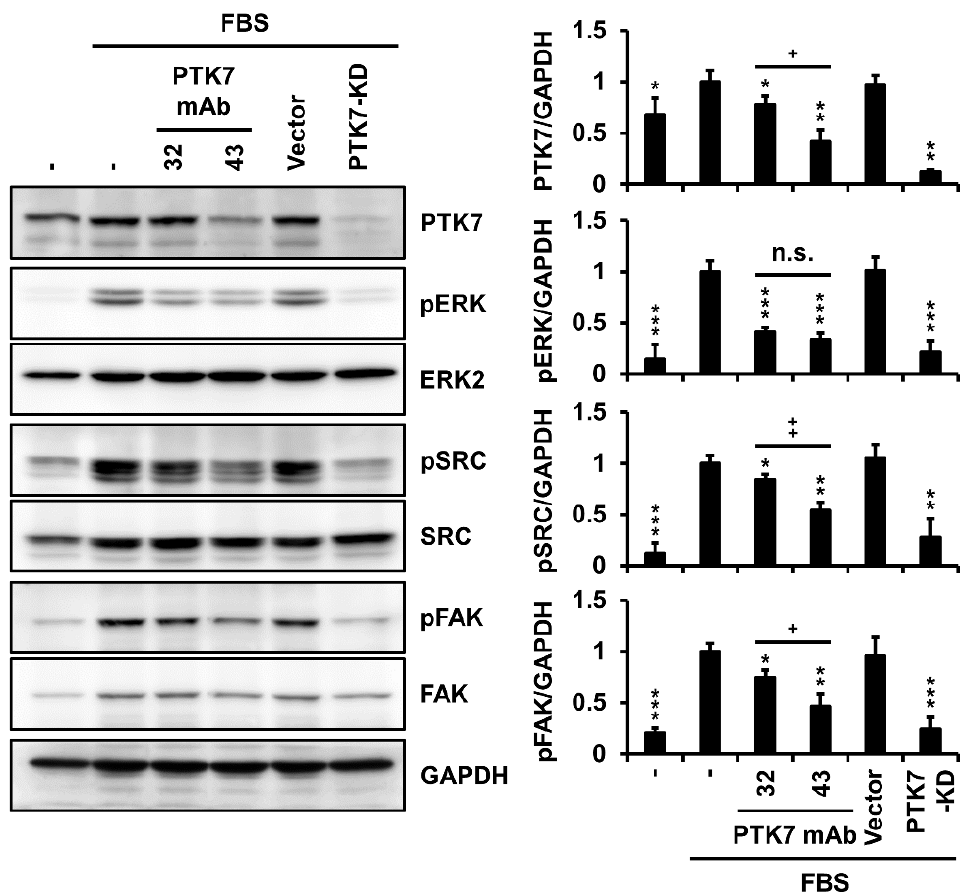
Figure 5. PTK mAbs inhibit activation of ERK, SRC, and FAK in KYSE-30 cells. KYSE-30 cells were incubated in DMEM/F12 medium with or without 2% FBS in the presence of PTK7 mAb (10 μg/mL) for 24 h. KYSE-30 cells infected with the vector or PTK7 knockdown viruses were used as controls. Cell lysates were subjected to Western blot analysis using PTK7, pERK, ERK, pSRC, SRC, pFAK, FAK, and GAPDH antibodies. Phosphoprotein/GAPDH ratio was quantitated using ImageJ software. Each bar represents the mean ± SD of three independent experiments: * p < 0.05, ** p < 0.01, or *** p < 0.001 vs. cells treated with FBS alone; + p < 0.05, ++ p < 0.01, or n.s. (not significant) between PTK7 mAb-32 and PTK7 mAb-43.